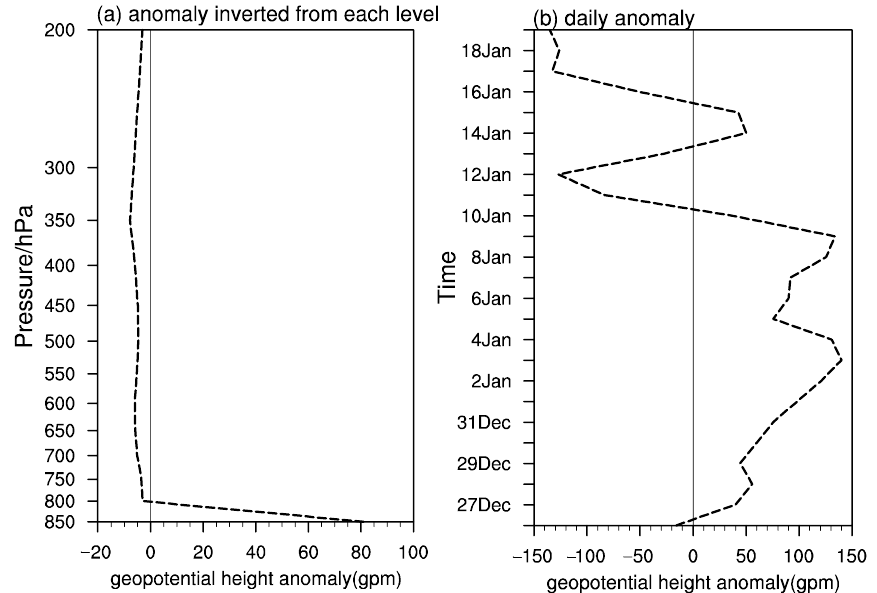
Figure 8. ( a ) 850 hPa geopotential height anomaly averaged over (42 ◦ N–47 ◦ N, 80 ◦ E–90 ◦ E) inverted from the piecewise PV inversion on each level averaged from 28 December 2020 to 4 January 2021. ( b ) same as ( a ) but for daily geopotential height anomaly inverted from the 850 hPa PV.